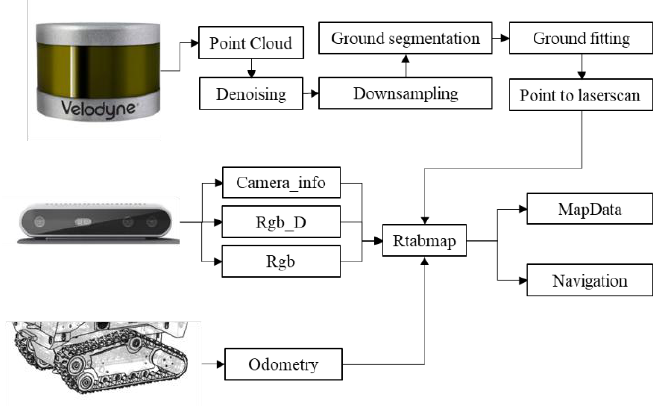
Figure 1. System framework.